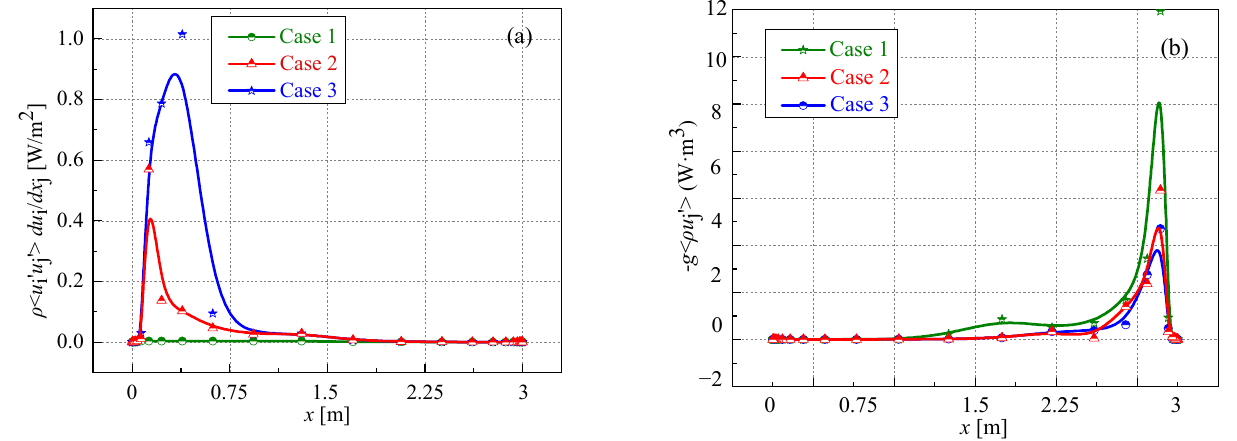
Figure 10. Turbulence on the given planes along the x -axis in Case 1, Case 2, and Case 3: ( a ) generation of turbulent kinetic energy; ( b ) generation of buoyant force.